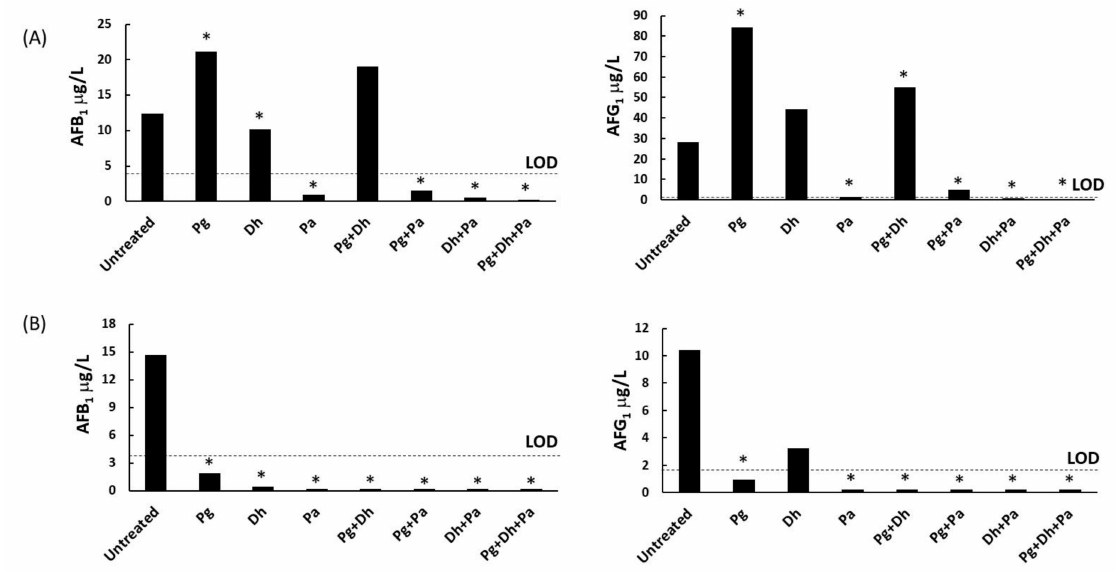
Figure 2. Effect of different combinations of biopreservative agents in aflatoxin B 1 (left) and G 1 (right) production by Aspergillus parasiticus in yeast extract sucrose broth ( A ) and calcium-enriched yeast extract sucrose broth ( B ) after 15 days. Pg: PgAFP; Dh: Debaryomyces hansenii ; Pa: Pediococcus acidilactici . LOD: Limit of detection. * Means are significantly different from untreated batch ( p ≤